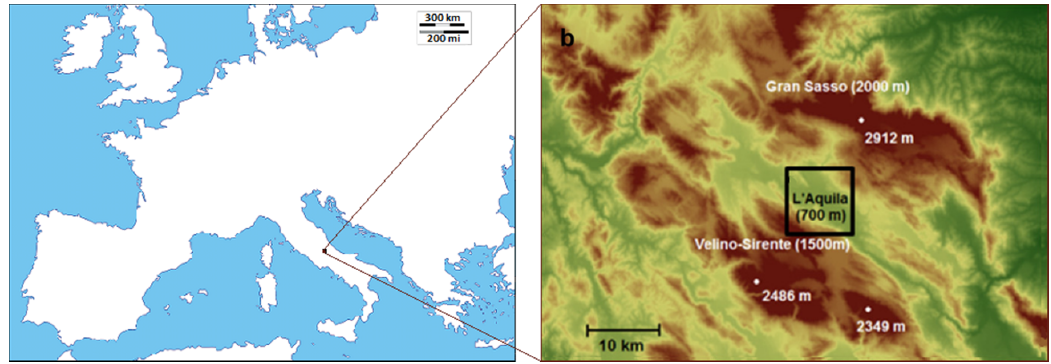
Figure 5. L’Aquila, Italy (42°22 ′ N, 13°21 ′ E). Topography of the region of interest.